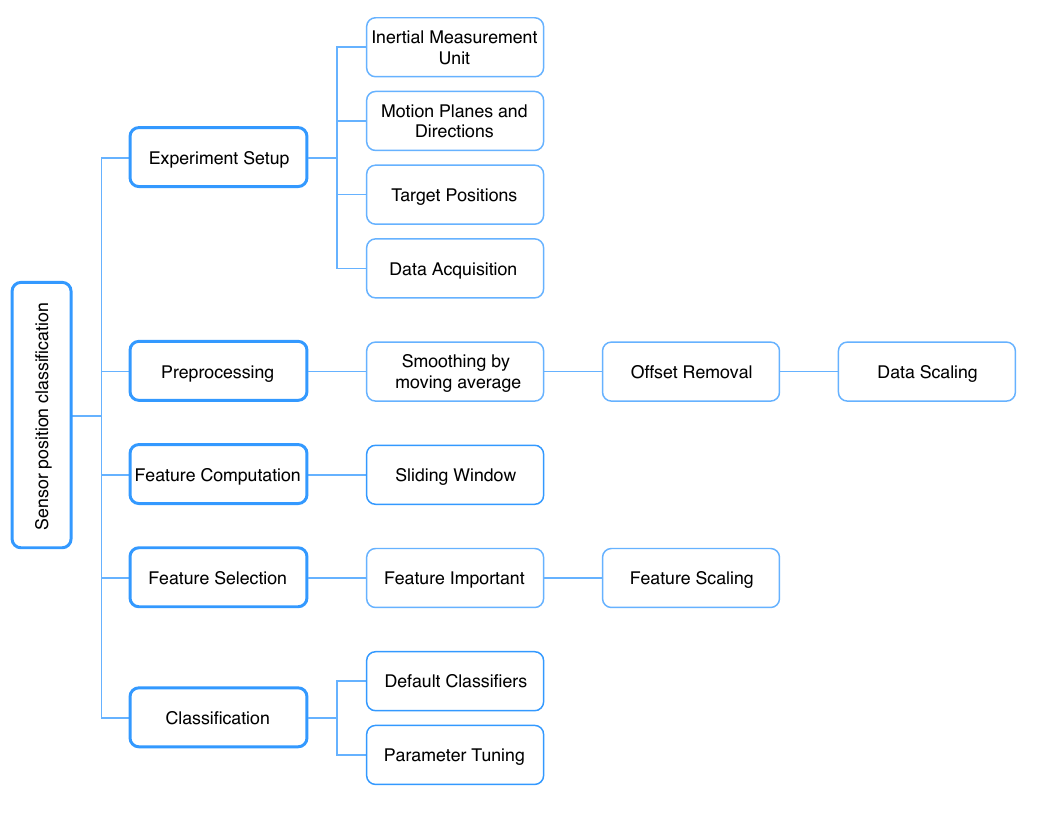
Figure 1. Overview of sensor position